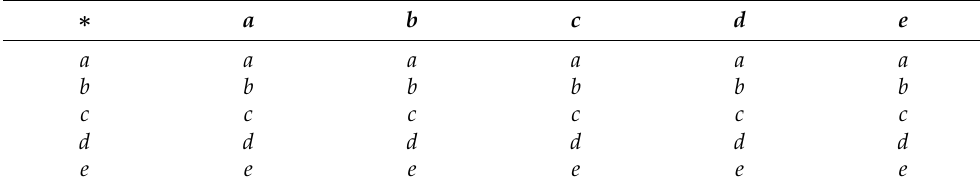
Table 4. This is a generalized